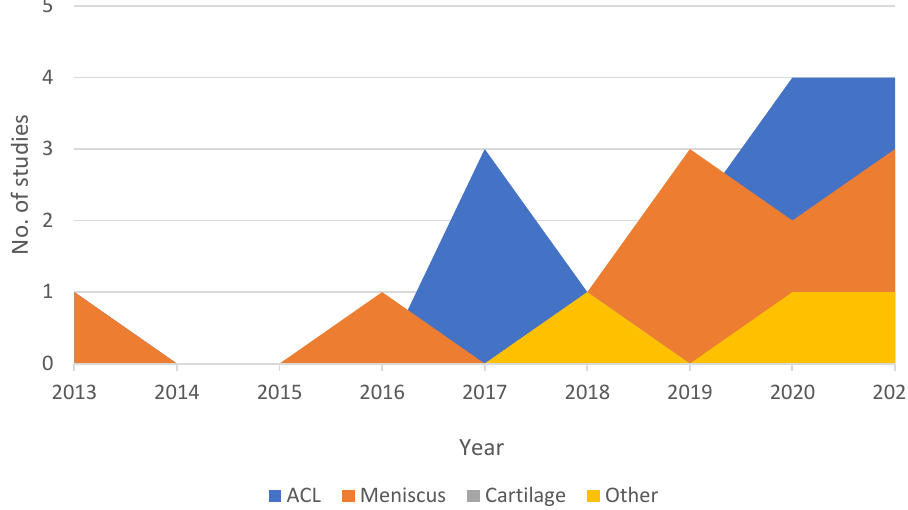
Figure 4. Temporal evolution chart depicting the number of ML papers per category published each year since 2013.